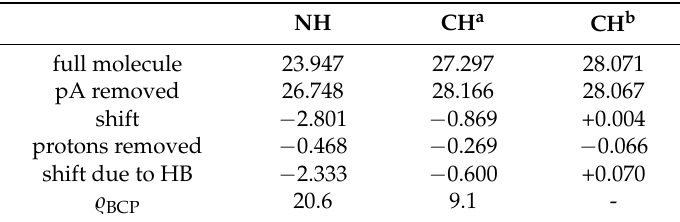
Table 3. NMR isotropic shielding (ppm) of models of the β -sheet structure in proteins shown in Figure 4, along with density at bond critical points ( (cid:36) BCP ) in 10 − 3 au.